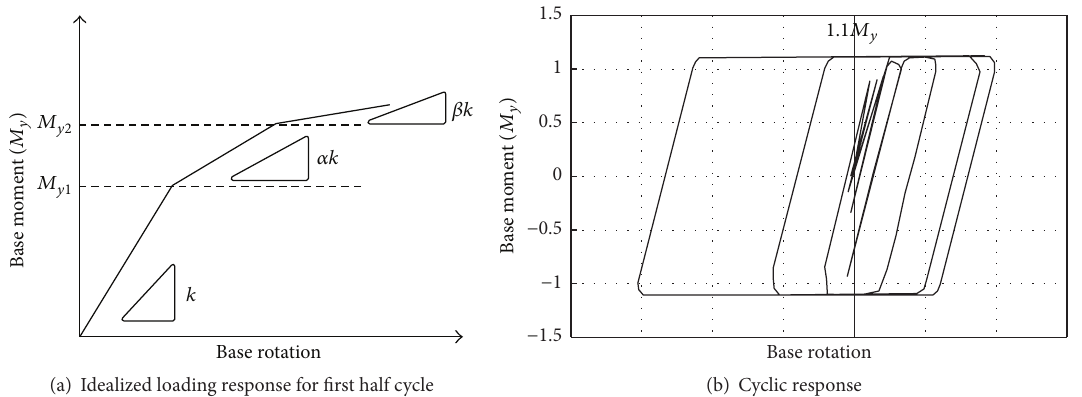
Figure 5: Menegotto-Pinto hysteretic loop.